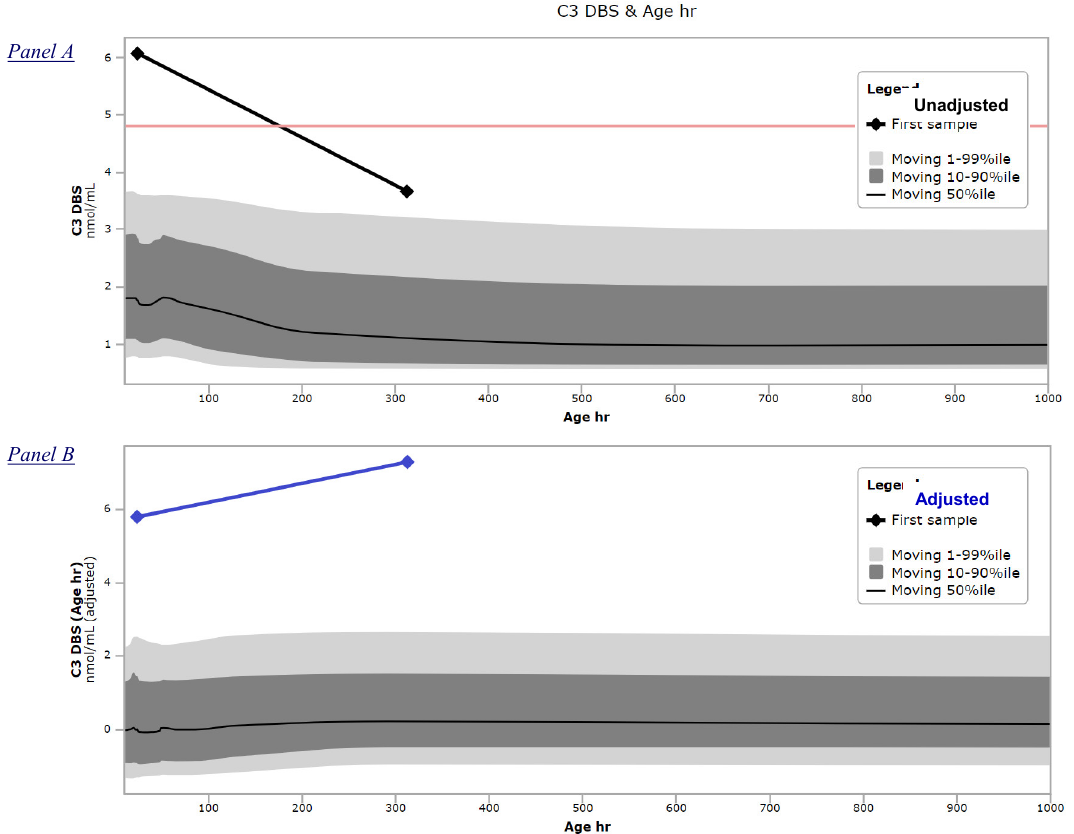
Figure 4. CLIR productivity tool “Marker vs. Covariate plot”. Panel ( A ) Unadjusted moving percentiles of C3 actual values in the age range 10–1000 h, linear scale. Black diamonds, connected by a line, represents from left to right the C3 values of the initial (6.07 nmol / mL) and repeat (3.67 nmol / mL) samples, respectively. Red line corresponds to the cuto ff value of the testing laboratory in use at the time. Panel ( B ) Adjusted moving percentiles of C3 in the age range 10–1000 h. Blue diamonds, connected by a line, represent from left to right the C3 values after adjustment for age of the initial and repeat samples,